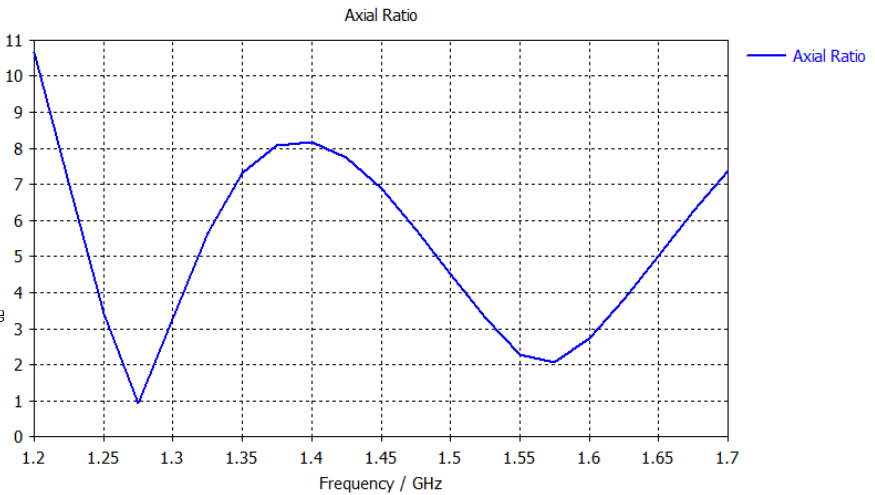
Figure 4. Radiating element simulated axial ratio expressed in